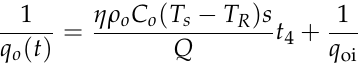
Figure 8. Comparison of oil production rate for conventional CSS and E-CSS. (2)